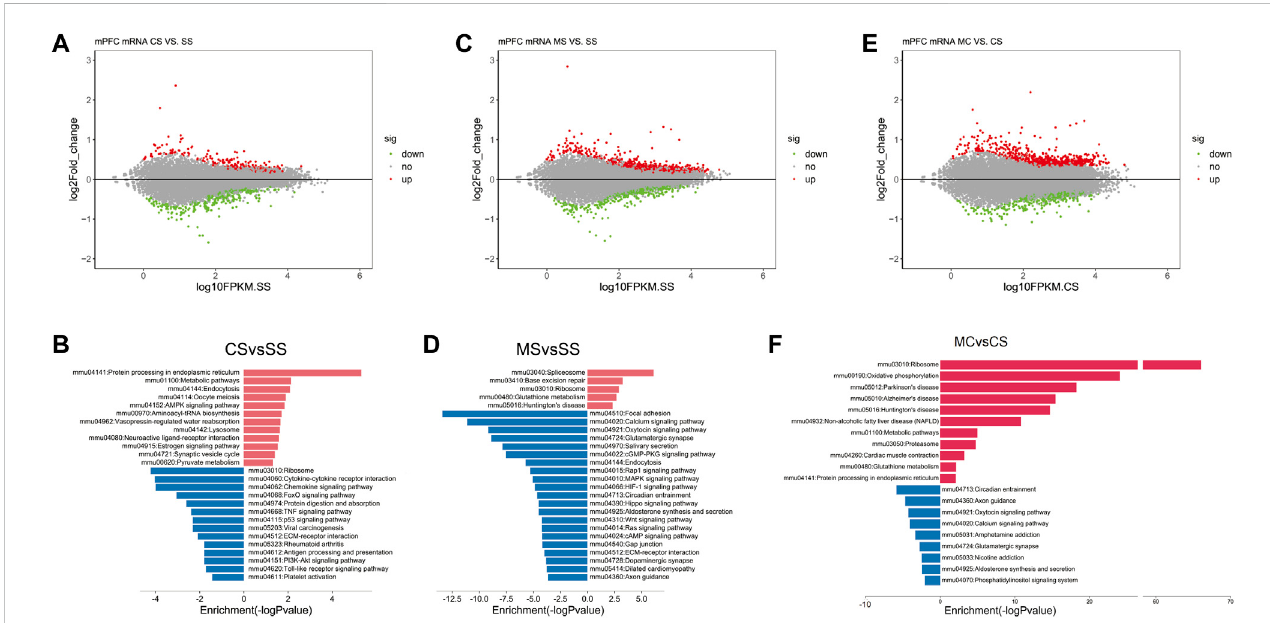
FIGURE 1 Cocaine and L-methionine (MET) cause broad changes to the transcriptome. mRNA from the prefrontal cortexes (PFCs) of SS (saline + saline), CS (saline + cocaine),MS(MET+saline),andMC(MET+cocaine)miceweresubjectedtoRNAsequencingandanalysisasdescribedinthemethods. (A) MA-plot[M(logratios);A (mean average)] of differentially expressed genes (DEGs) in the CS group ( p < 0.1). The log2 fold change values for CS vs. SS are plotted against the average log expression values (fragments per kilobase of transcript per millionmapped reads [FPKM]). (B) Enriched pathwaysof signi fi cantly down andupregulatedgenesin the CS group ( p < 0.05). (C) MA-plot of differentially expressed genes (DEGs) in the MS group ( p < 0.1). Log2 fold change values for MS vs. SS are plotted against the average log expression values (FPKM). (D) Enriched pathways of signi fi cantly down and upregulated genes in the MS group ( p < 0.05). (E) MA-plot of DEGs in the MC group ( p < 0.1). Log2 fold change values for MC vs. CS are plotted against the average log expression values (FPKM). (F) Enriched pathways of signi fi cantly down and upregulated genes in the MC group ( p < 0.05). In the MA plot, upregulated and downregulated DEGs are shown in red and green,